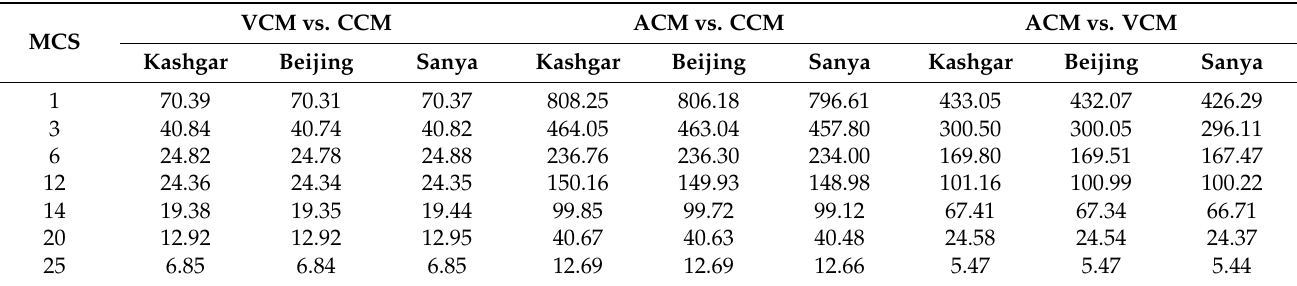
Table 8. TEF improvement percentage